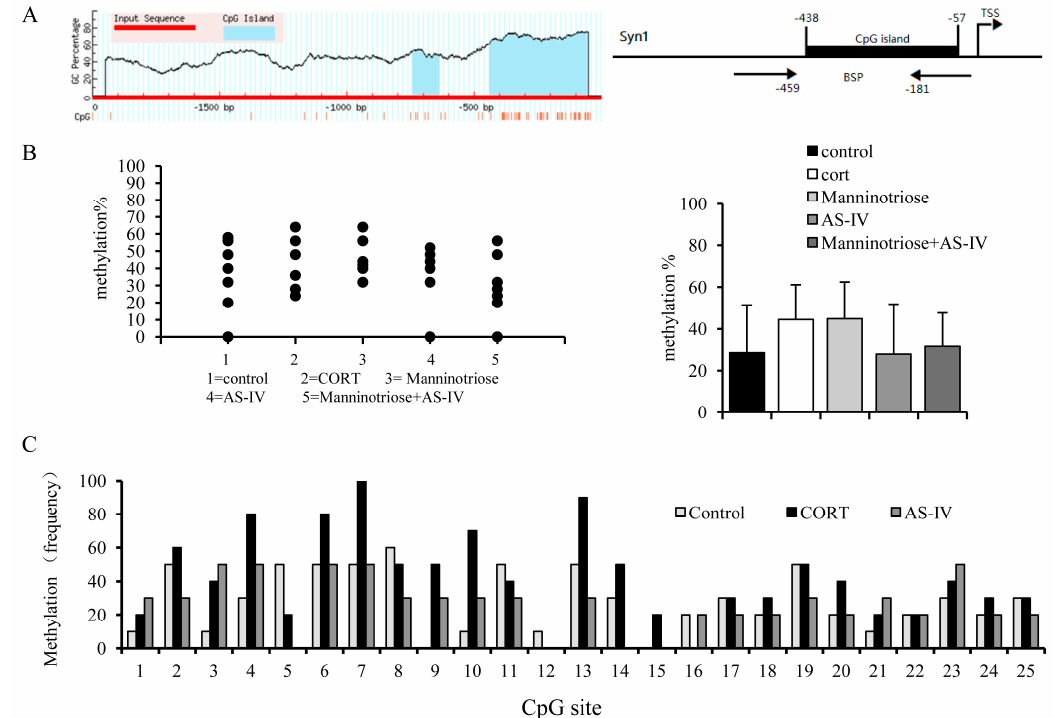
Figure 5. Effects of Manninotriose and AS-IV on SYN1 gene methylation in CORT injured hippocampal neurons. ( A ) The genomic structure of SYN1 including the location of the CpG islands relative to the TSS. Tss, transcriptional start site; The TSS numbers indicate the nucleotide distance from the TSS. BSP indicates the location of bisulfite sequencing PCR primers. ( B ) Methylation rate of individual clones ( n = 10) across 25 CpGs sites of the SYN1 CpG island, as determined by BSP. ( C ) Methylation analysis of individual CpG sites ( n = 10).